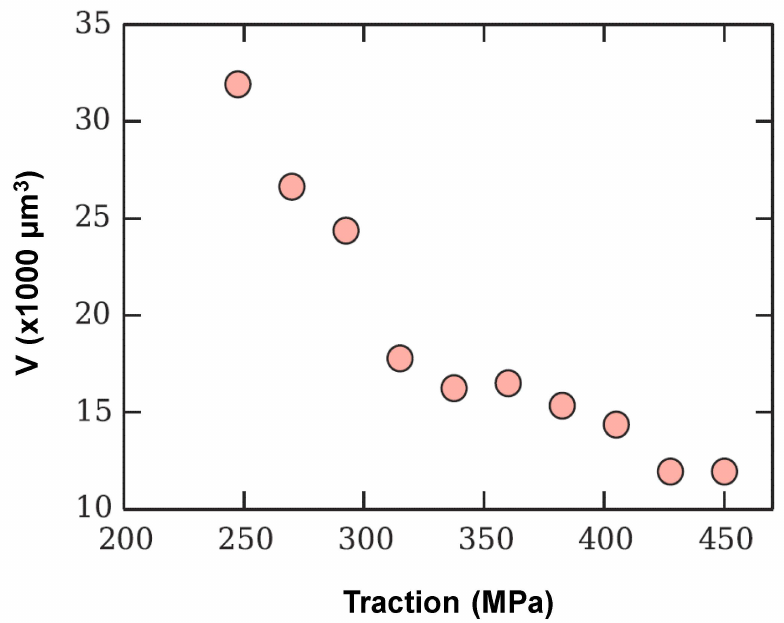
Figure 7. The average volume of the fractured particles in each load step during simulation.